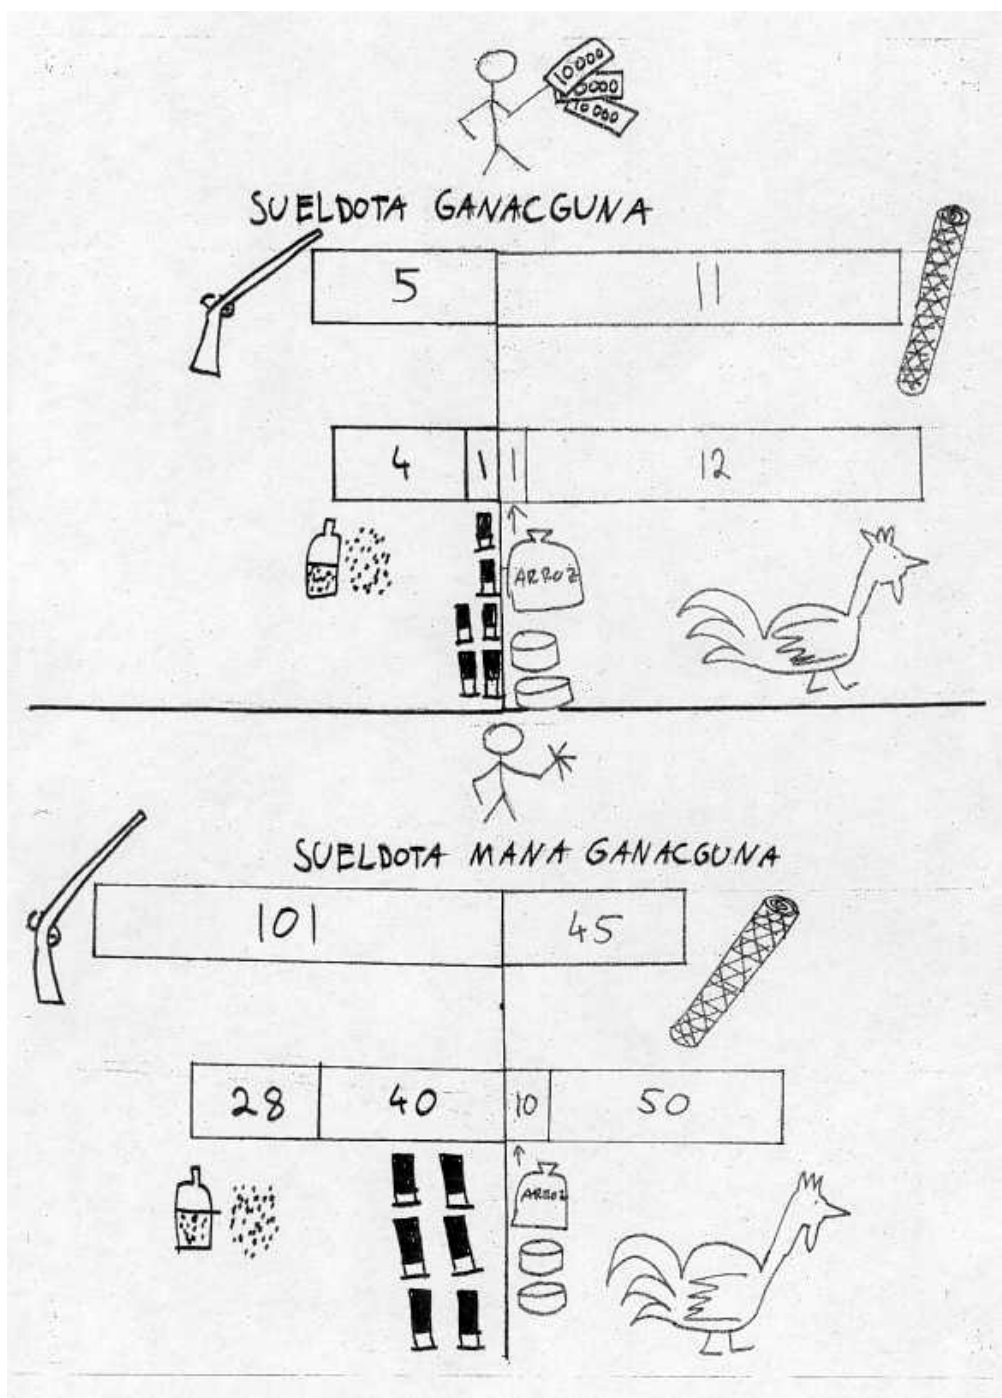
Fig. 3. Results split between people with and without steady